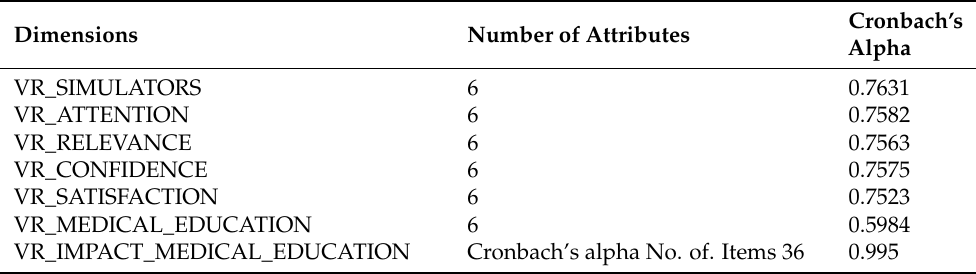
Table 1. Reliability study result for impact of a VR simulator on medical education using the ARCS model of learning motivation dimensions.